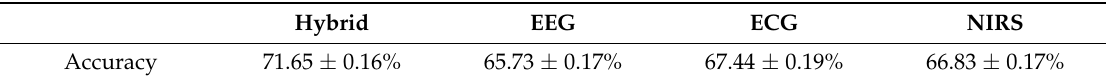
Table 8. Accuracy comparison of stand-alone and hybrid.